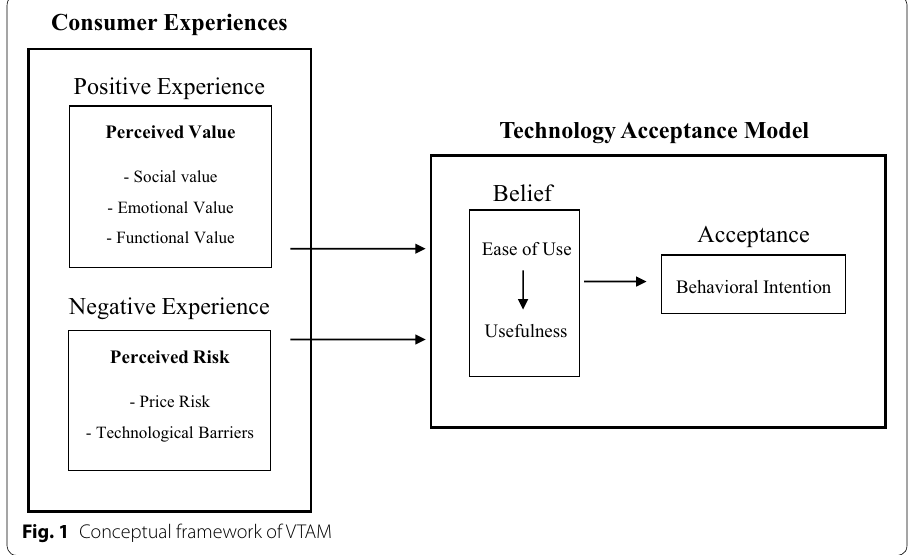
Fig. 1 Conceptual framework of